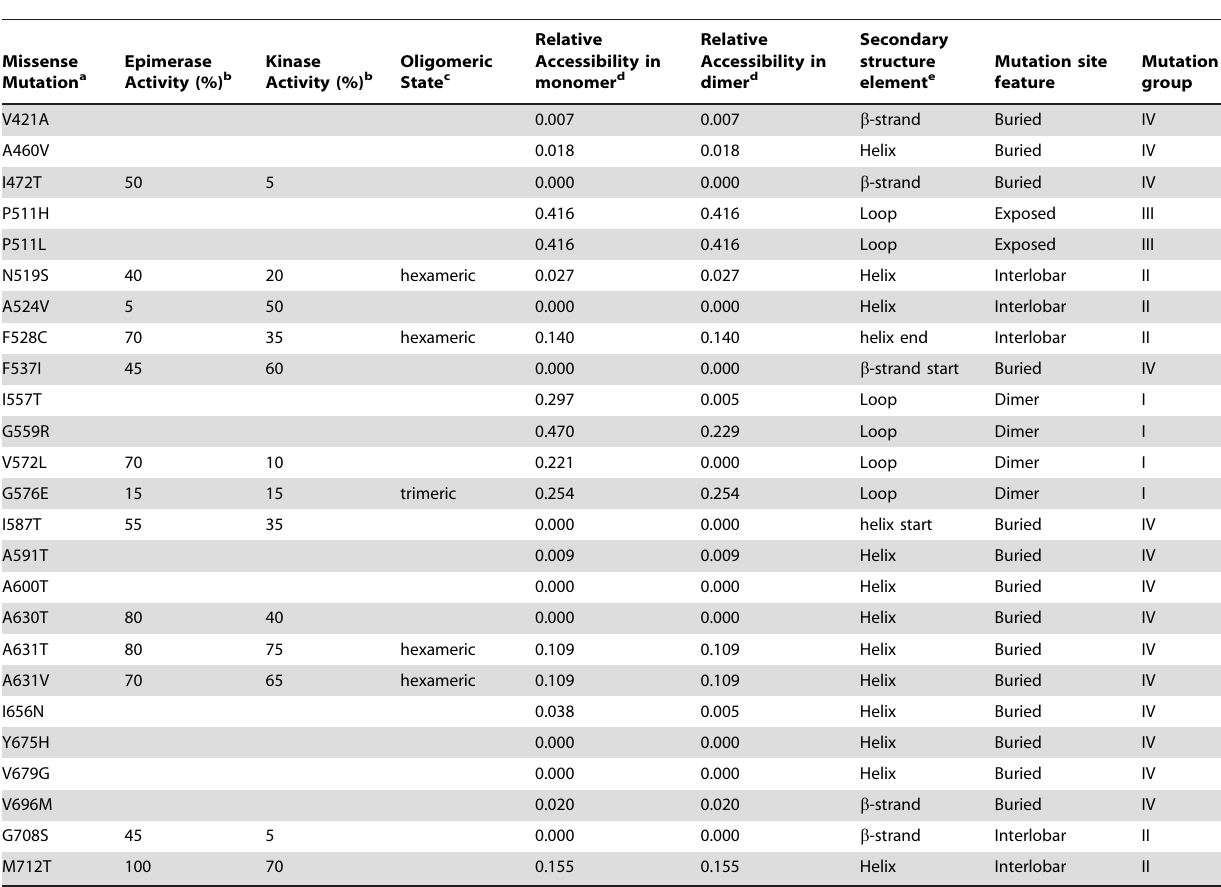
Table 1. Structural analysis of HIBM-associated missense mutations in the GNE kinase